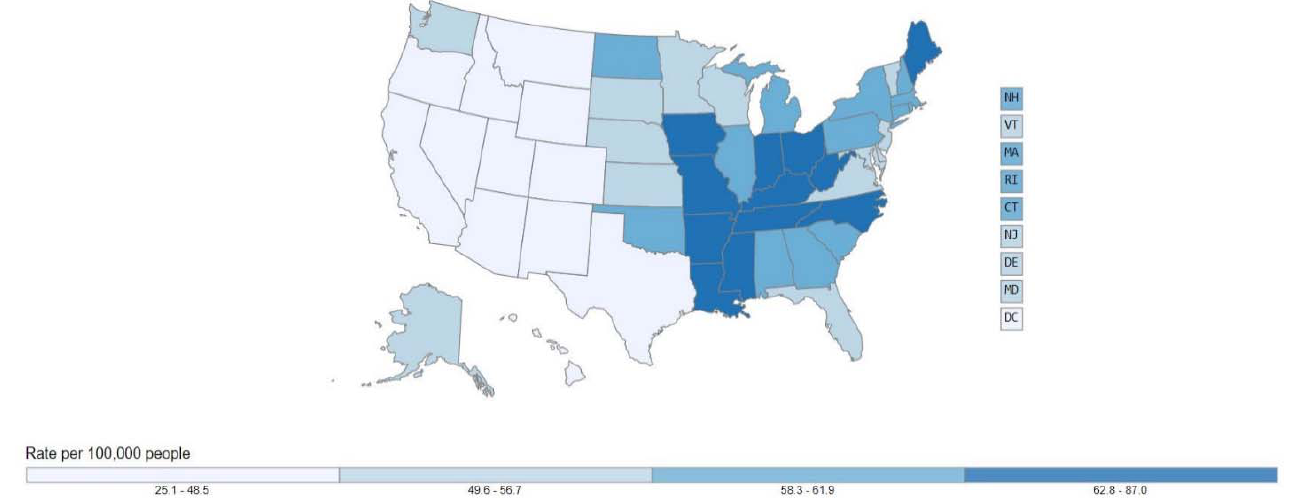
Figure 1. Cancer of the Lung and Bronchus, United States, 2017, Rate per 100,000 people, All ages, all races/ethnicities, Male and Female. Source: Centers for Disease Control and Prevention.